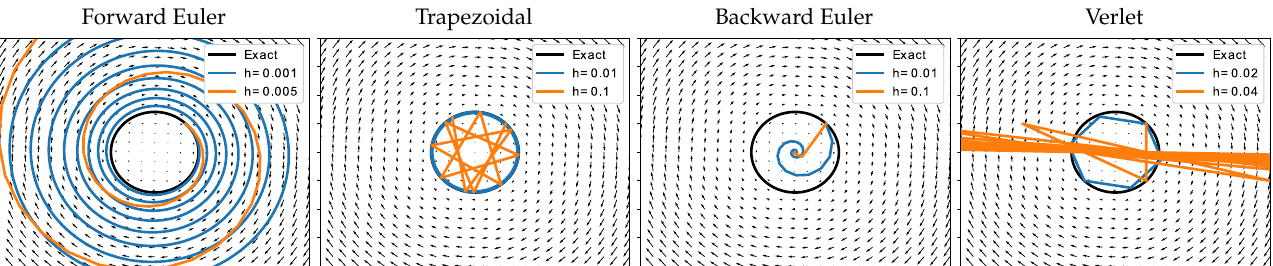
Figure 2. Phase diagrams of different numerical solutions of the system in